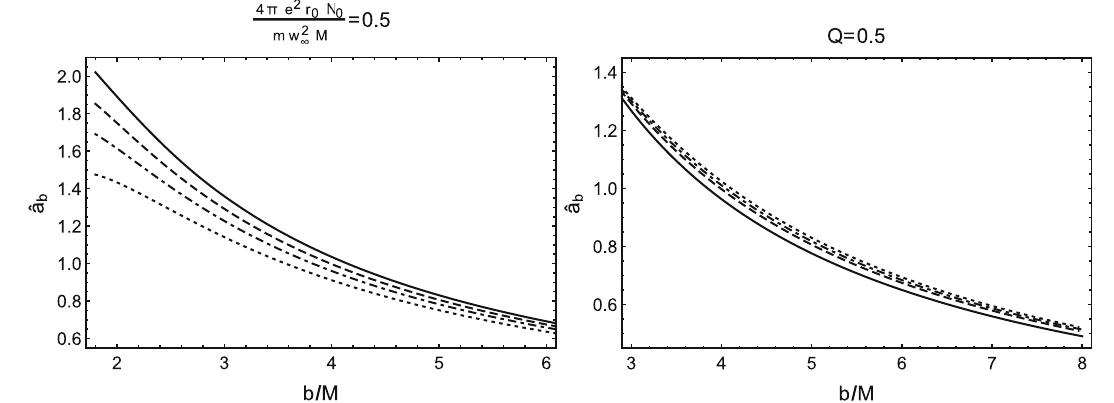
Fig. 8 Deflection angle ˆ α b as a function of the impact parameter b for different charge and plasma values. In the left panel the values of Q (top to bottom) are 0, 0.5, 0.7 and 0.9 and in the right panel the values 4 π e 2 N 0 r 0 (bottom to top) are 0, 0.5, 0.7 and m ω 2 ∞ M